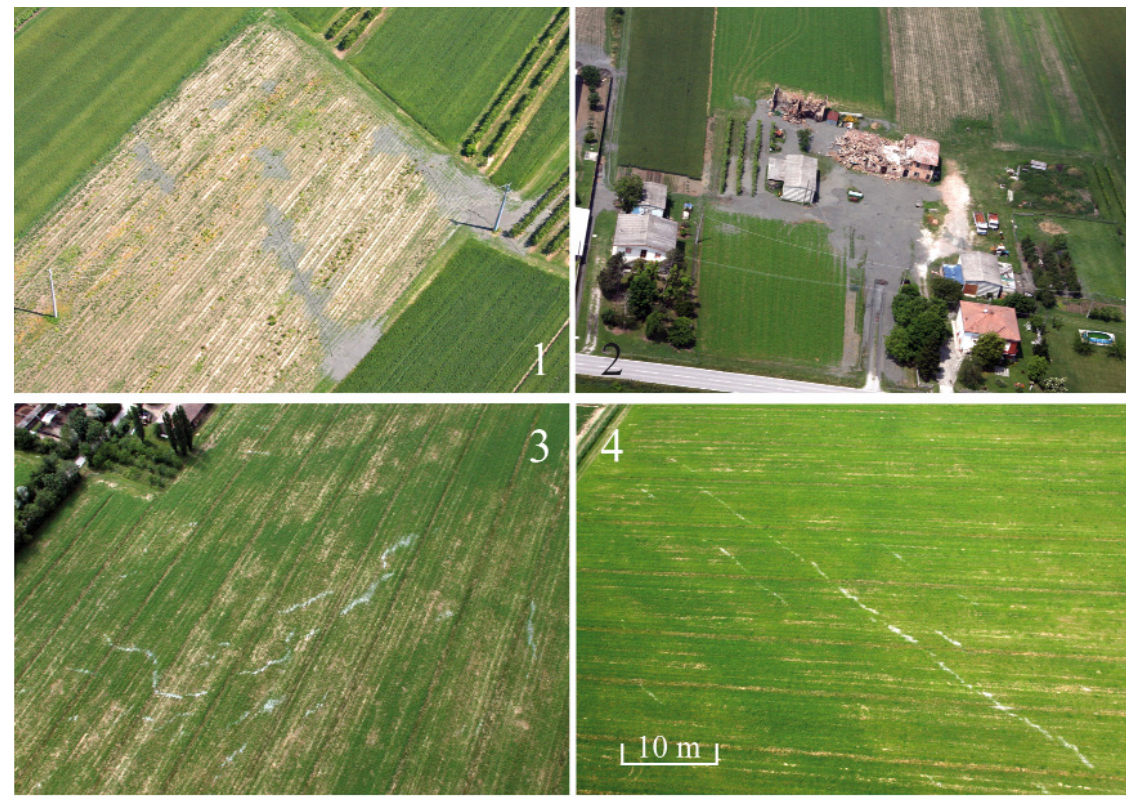
Figure 4. 1) Fractures near Sant'Agostino (Ferrara Province); 2) Eruption of sand North of San Carlo; 3), 4) These fractures retrace the forms of ancient watercourses, now abandoned (Modena